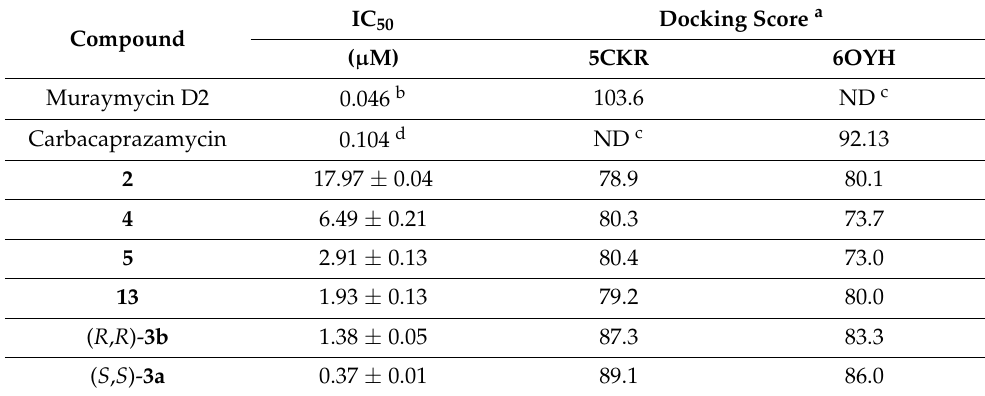
Table 2. Comparison of docking score in models 5CKR and 6OYH. IC 50 Docking Score Compound